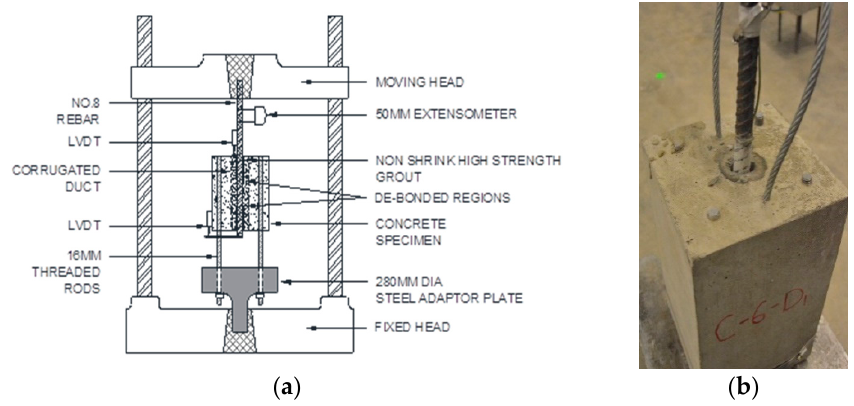
Figure 2. ( a ) Experimental set-up; ( b ) failed bars by shearing of the grout keys at 6 d b embedment.